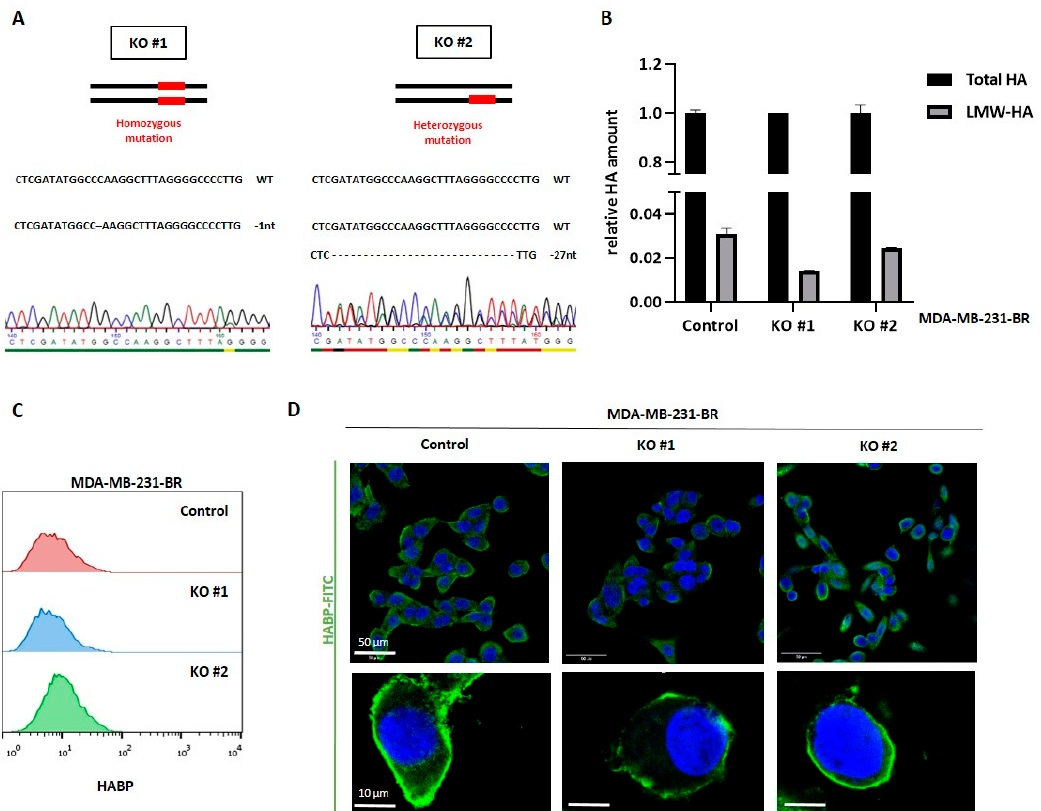
Figure 3. Generation of HYAL1 knockout (KO) in MDA-MB-231-BR and characterization regarding their HA metabolism. ( A ) Two types of HYLA1 mutations generated by CRISPR/Cas9 in MDA-MB-231-BR cells were identified after Sanger sequencing in the corresponding sequencing chromatogram. Mutation features shown here include a homozygous single- base deletion in clone KO #1 (indicated as -1nt) and a larger deletion in only one allele of clone KO #2 (-27nt). ( B ) Bar graph displaying representative HA-ELISA results on secreted HA levels (one representative experiment with duplicates out of three experiments is shown ( n = 3)). The amount of LMW-HA is presented as a ratio of total HA (set as 1). ( C ) Multilayer